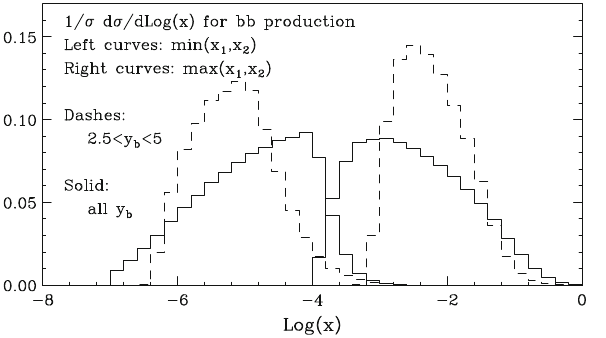
Fig. 7.3 Distribution of the smaller and larger values of the initial partons momentum fractions in inclusive b¯b events (solid) and in events with at least one b in the rapidity range 2 . 5 < | y | < 5